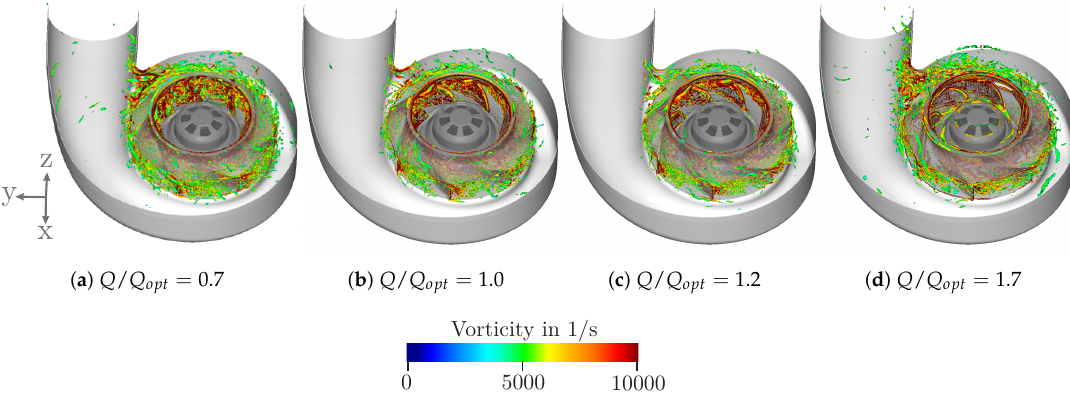
Figure 14. Instantaneous isosurface of λ 2 values lower than − 5 × 10 6 s 2 colored by vorticity